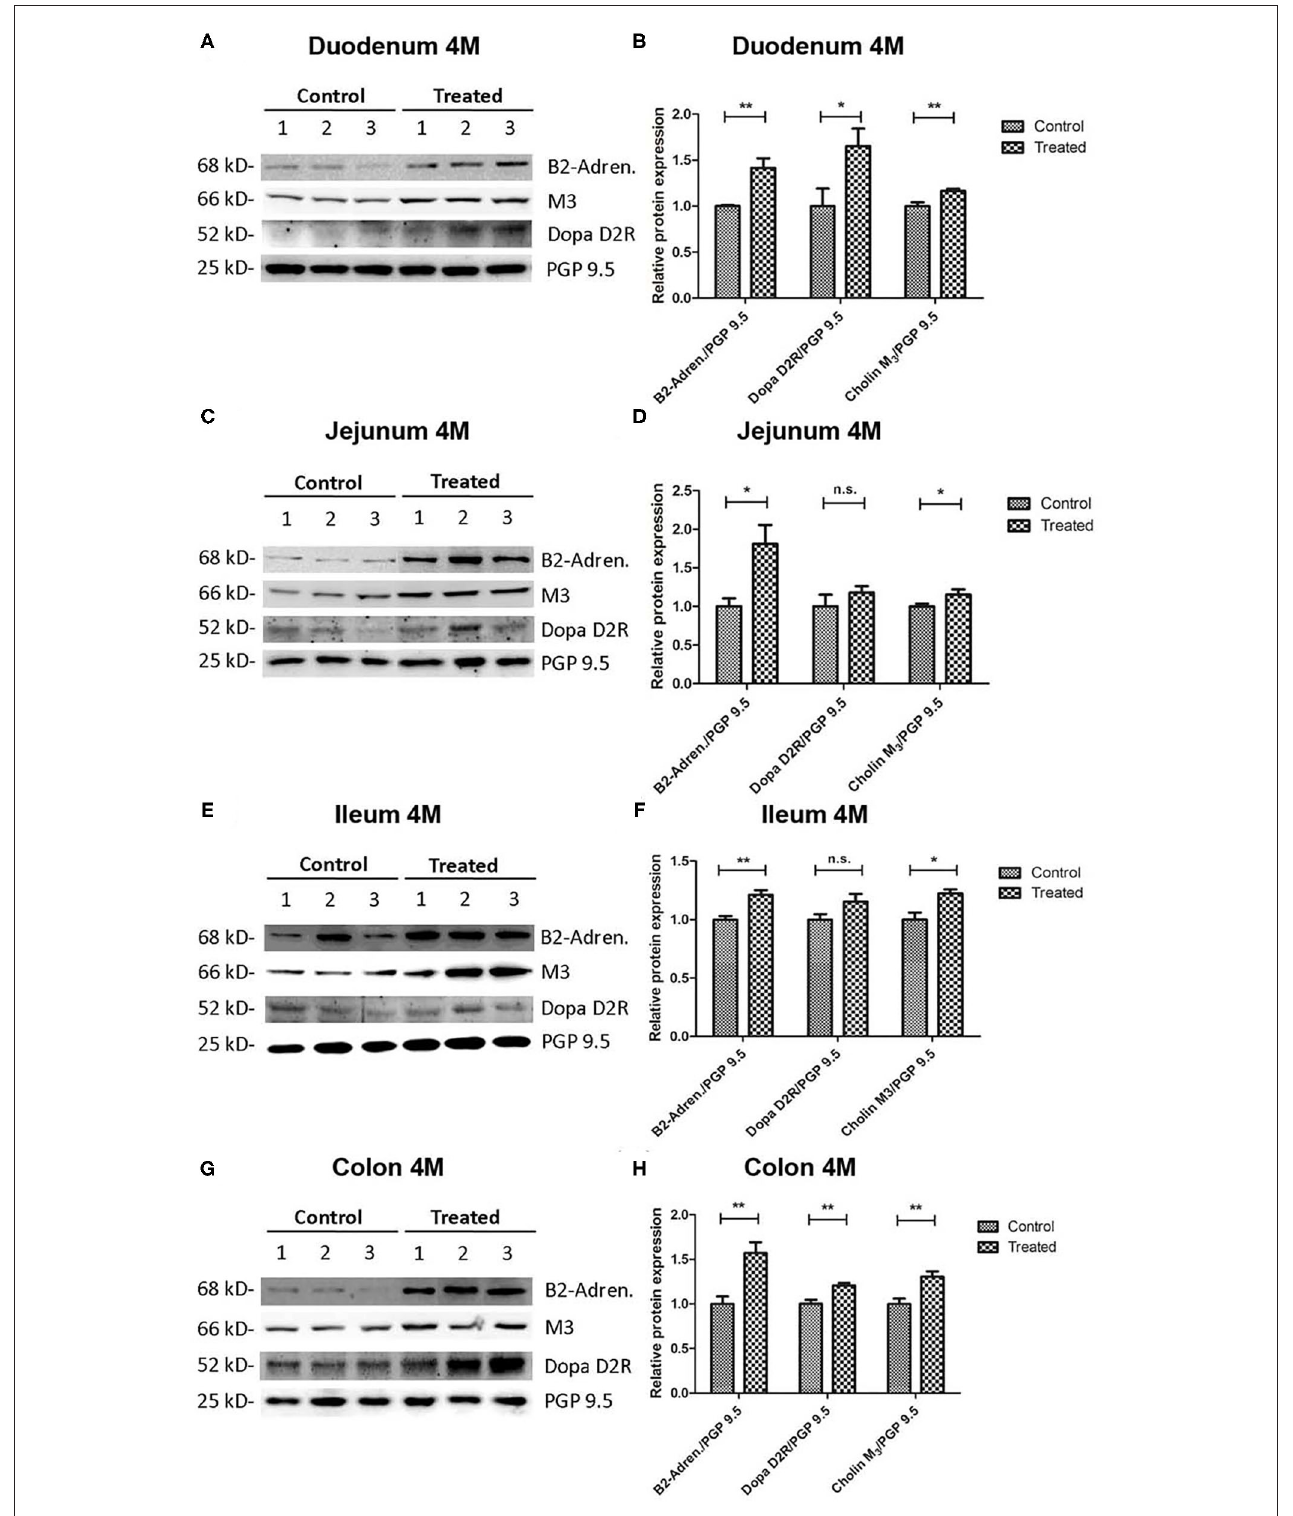
FIGURE 10 | Four-Month rotenone exposure induces an up regulation of the adrenergic (ß2-subunit), cholinergic (M3-muscarinic), and dopaminergic (D2) receptors in the gut. Westenr blots in (A,C,E,G) show 3 representative examples per exposure group for the protein levels of adrenergic (ß2-subunit) (B2-Adren.),